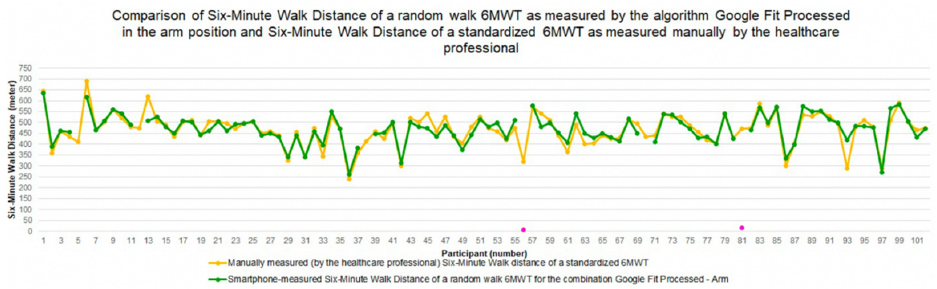
Figure 4. Six-minute walk distance for the random walk 6MWT as measured by the algorithm Google Fit Processed with the smartphone in the arm position and for the standardized 6MWT as measured manually by the healthcare professional.